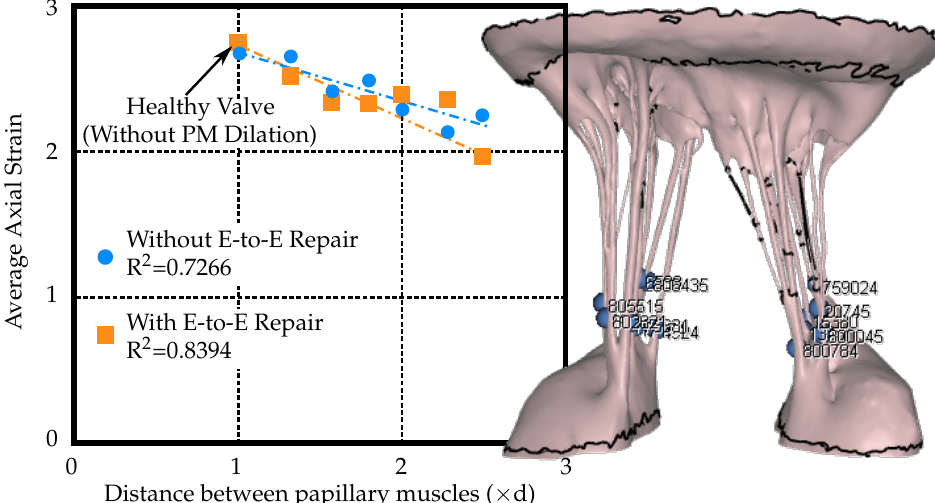
Figure 6. Average strain values in the chordae near the papillary muscles (PM) versus PM displacement (where ‘d’ is the distance between papillary muscles of the healthy valve model, i.e., without PM